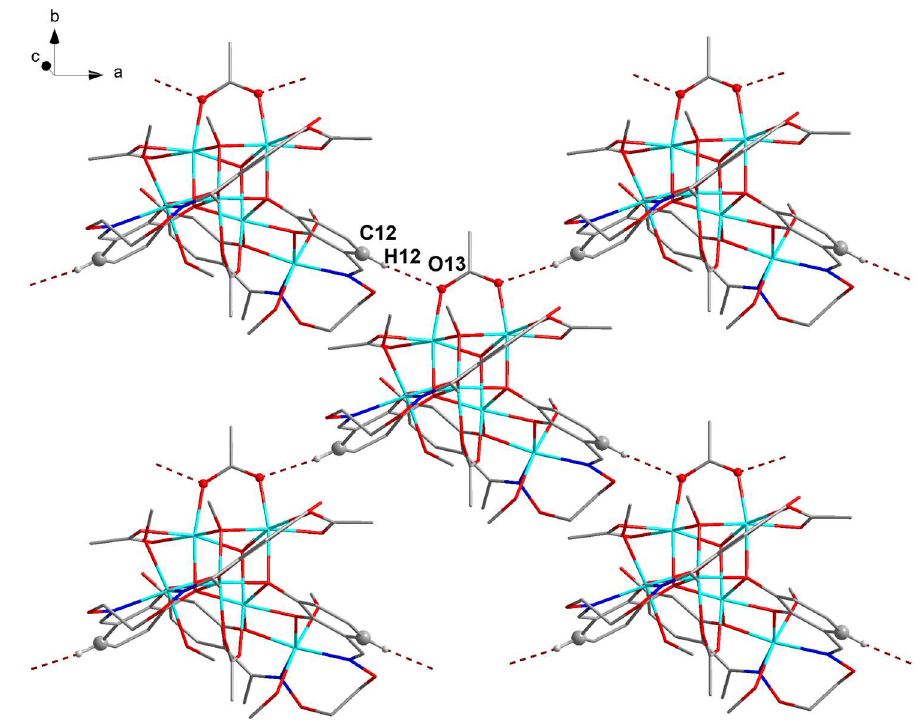
Figure 5. View of the 2D layered structure of the Co(II) coordination compound.